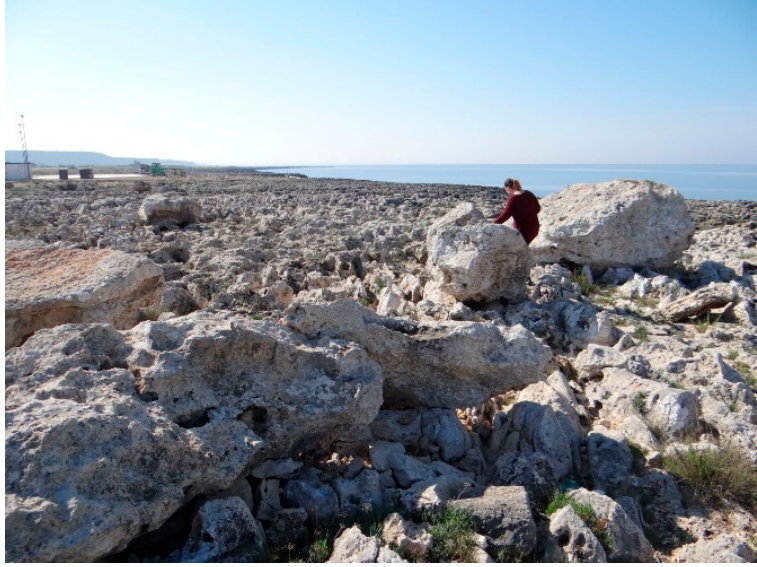
Figure 6. A view of large-size imbricated boulders resting on the low-elevated rocky platform occurring at Torre dell’Inserraglio site, along Profile S3.